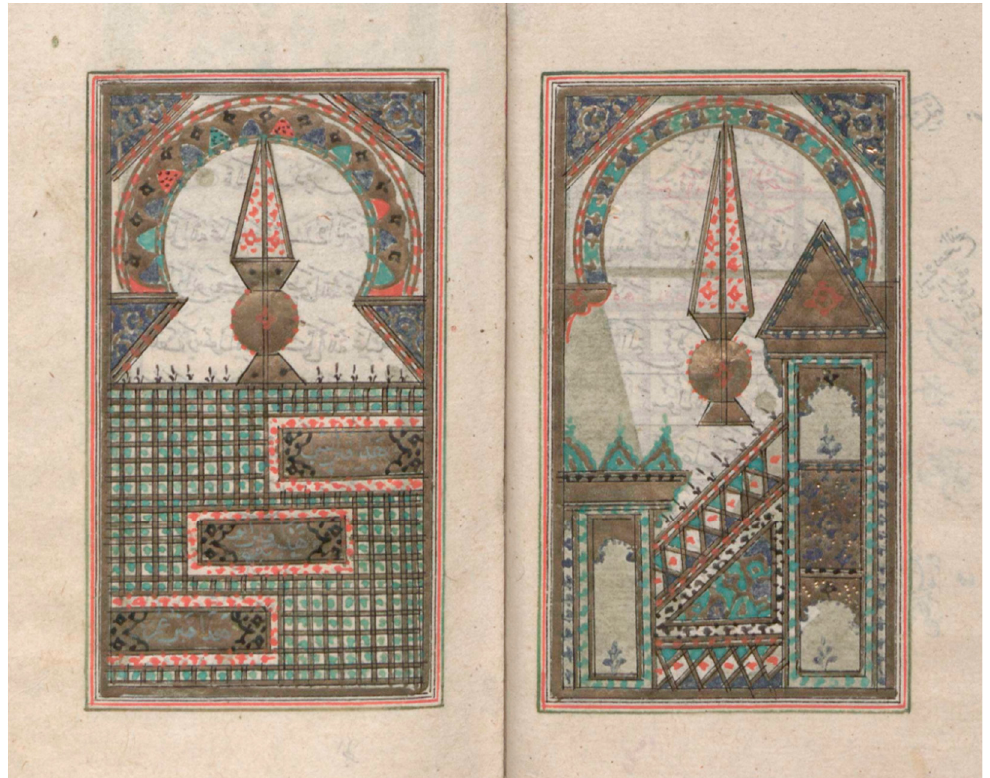
Figure 6. A fairly typical representative of the ‘traditional’ pairing of depictions of the Raw ḍ a with Mu ḥ ammad’s Minbar with decorative elaboration typical of the wider Ottoman world, from an Ottoman Syrian copy of the Dal ā ’il completed at some point in the eighteenth century. University Library of Leipzig, Vollers 200.